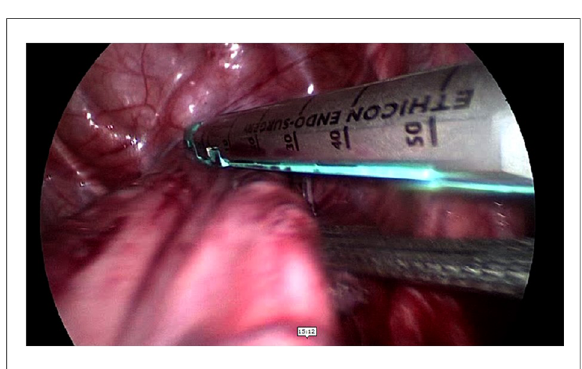
FIGURE 6 A gastrointestinal stapler was used to divide the aganglionic rectum as low as